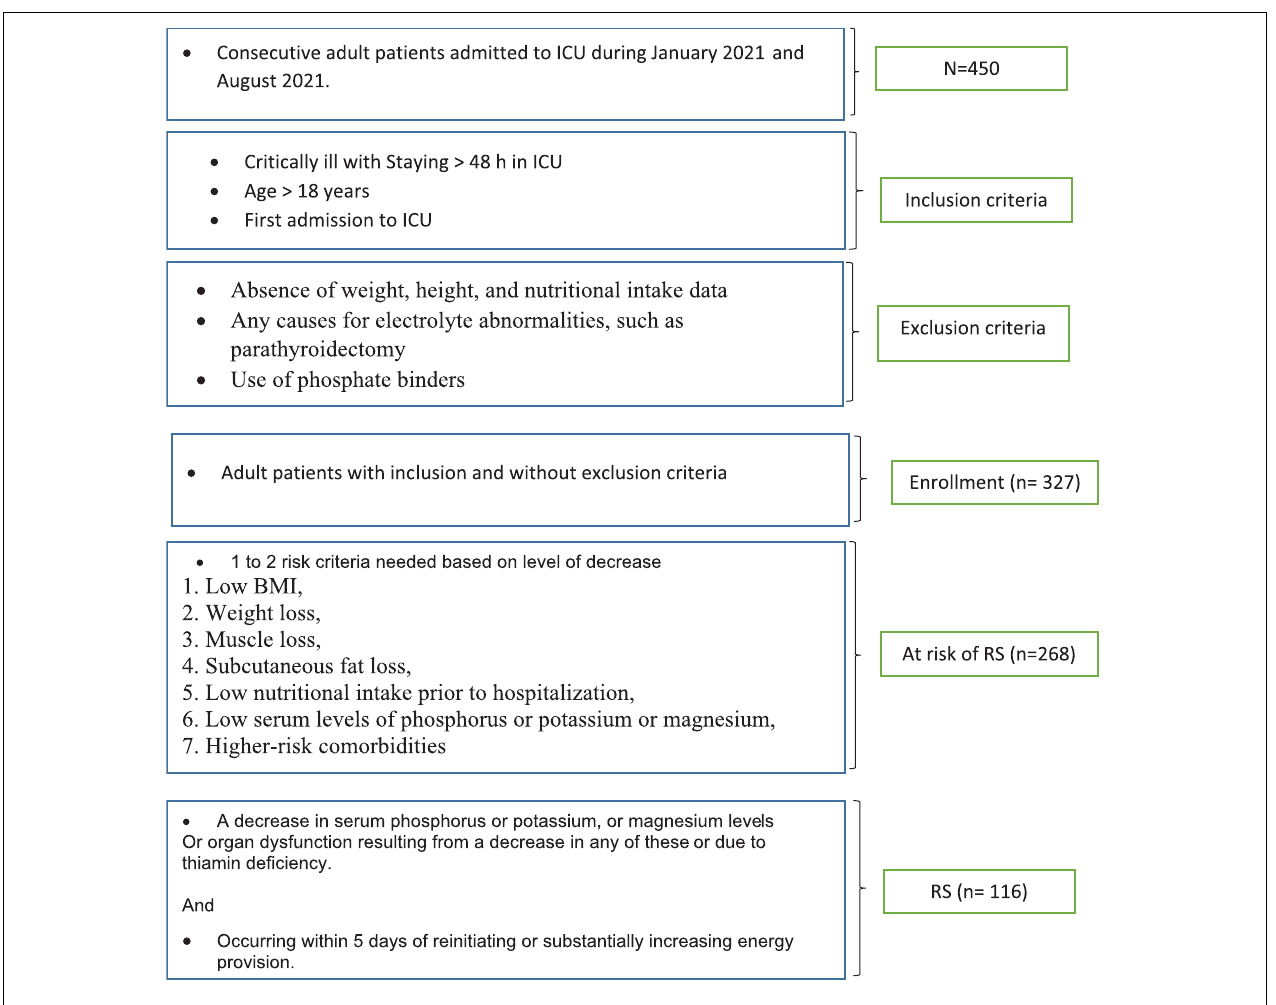
FIGURE 1 | Flowchart of